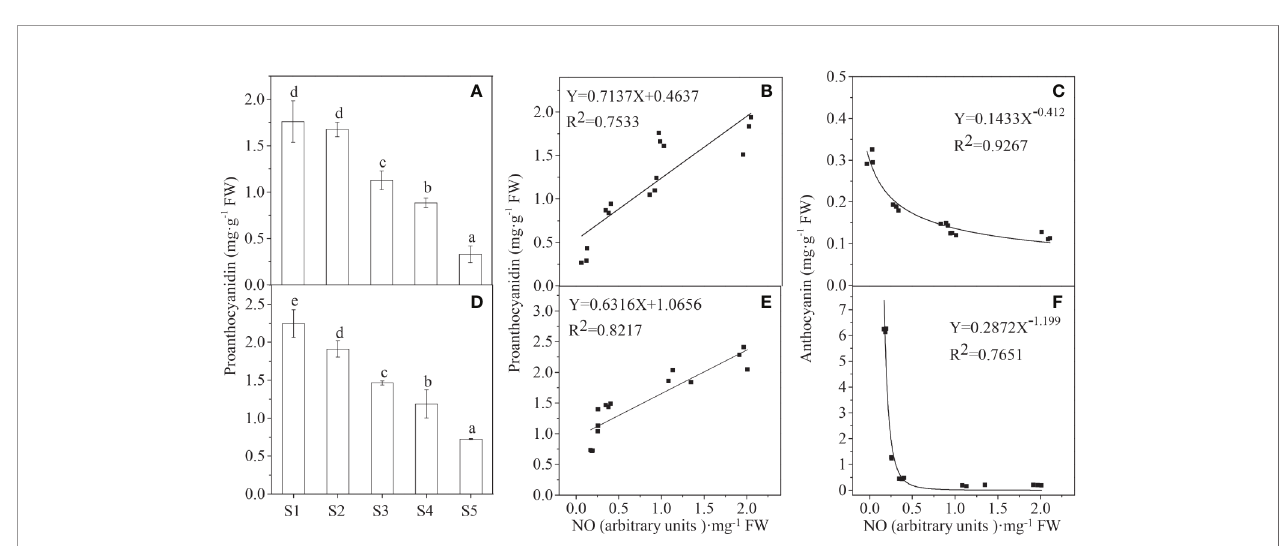
FIGURE 3 | The relationship between the NO release and the pigment content. Proanthocyanidin (PA) concentration declines progressively during the process of Lycium fruit ripening (A, D) , and there is a signi fi cant positive relationship between PA and NO (B, E) while a negative relationship between anthocyanin and NO (C, F) , both for YF (A – C) and BF (D, F) . For (B, F) , p < 0.05, and for (C, E) , p < 0.01. The error bars represent the SDs of three independent replicates. Different letters on the bars for the same species indicate signi fi cant differences between the treatments (p <